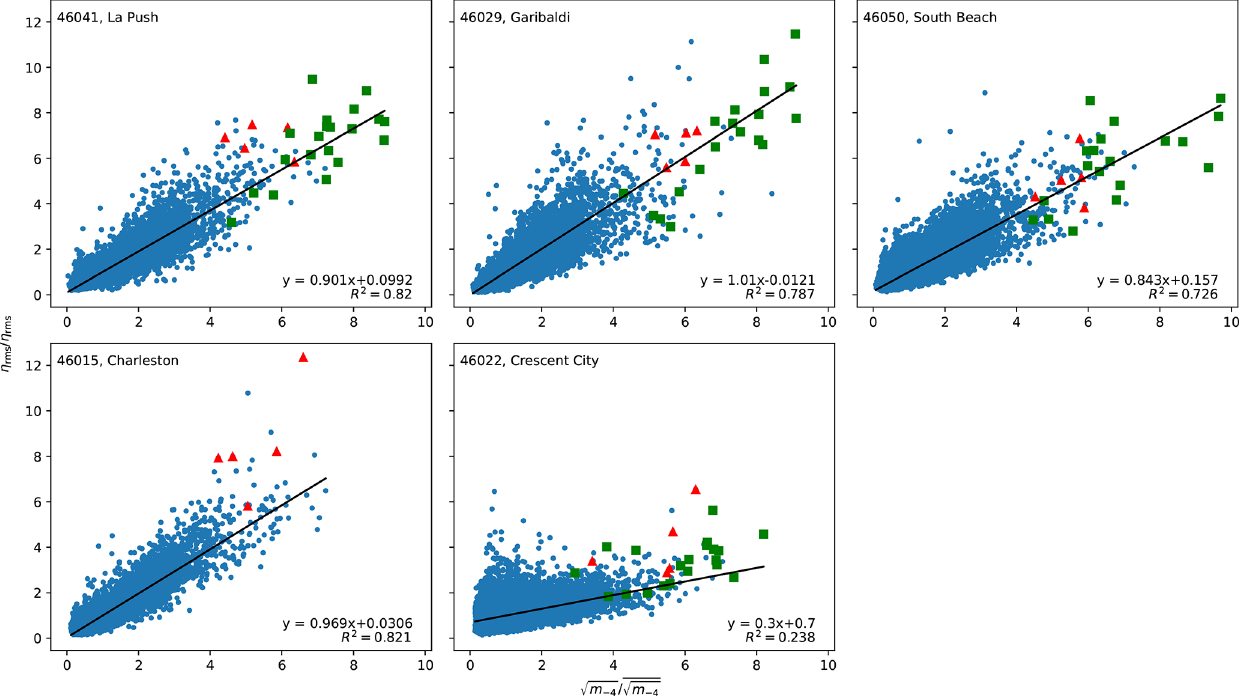
√ √ m − 4 / m − 4 from the offshore ocean wave spectra